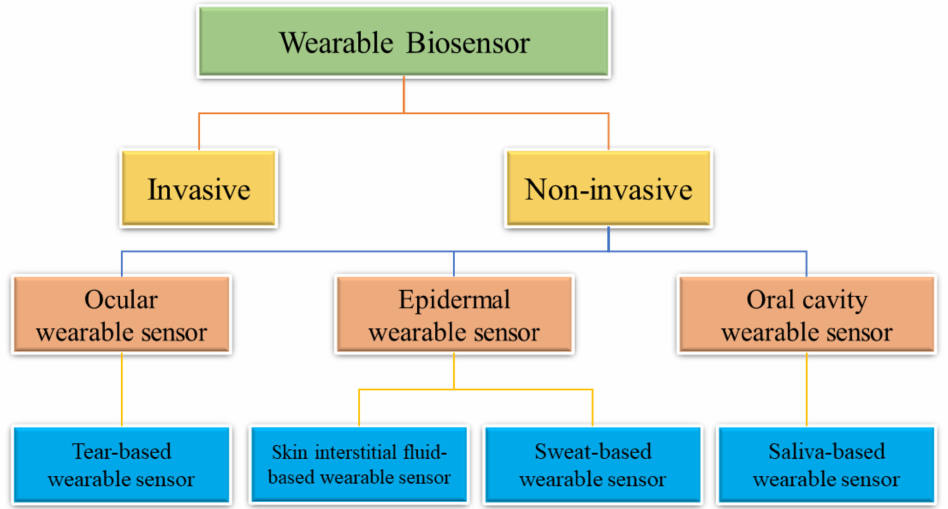
Figure 15. Wearable biosensor